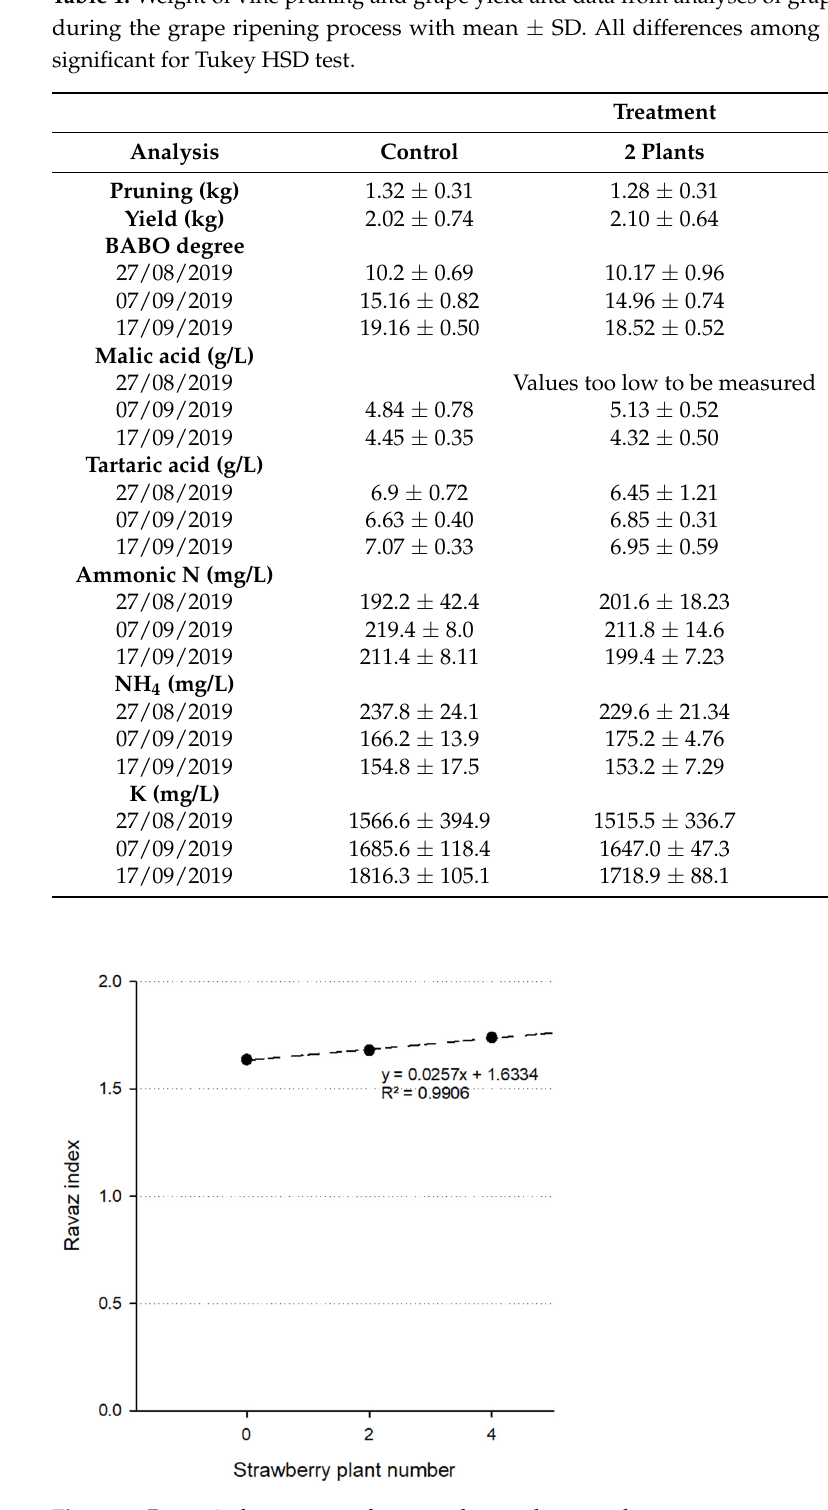
Figure 8. Ravaz index compared to strawberry plant